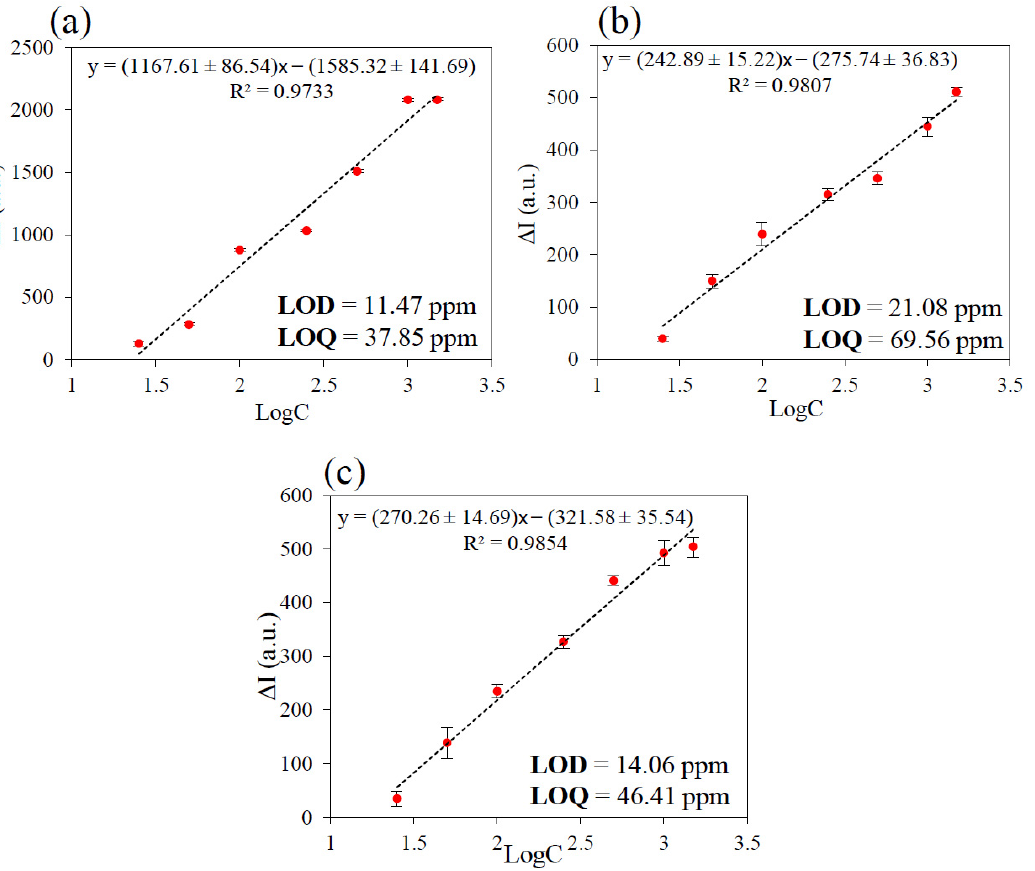
Figure 7. Calibration curve of planar optical waveguide response results for ( a ) HCl, ( b ) m-xylene, and ( c ) styrene from 25 to 1500 ppm.